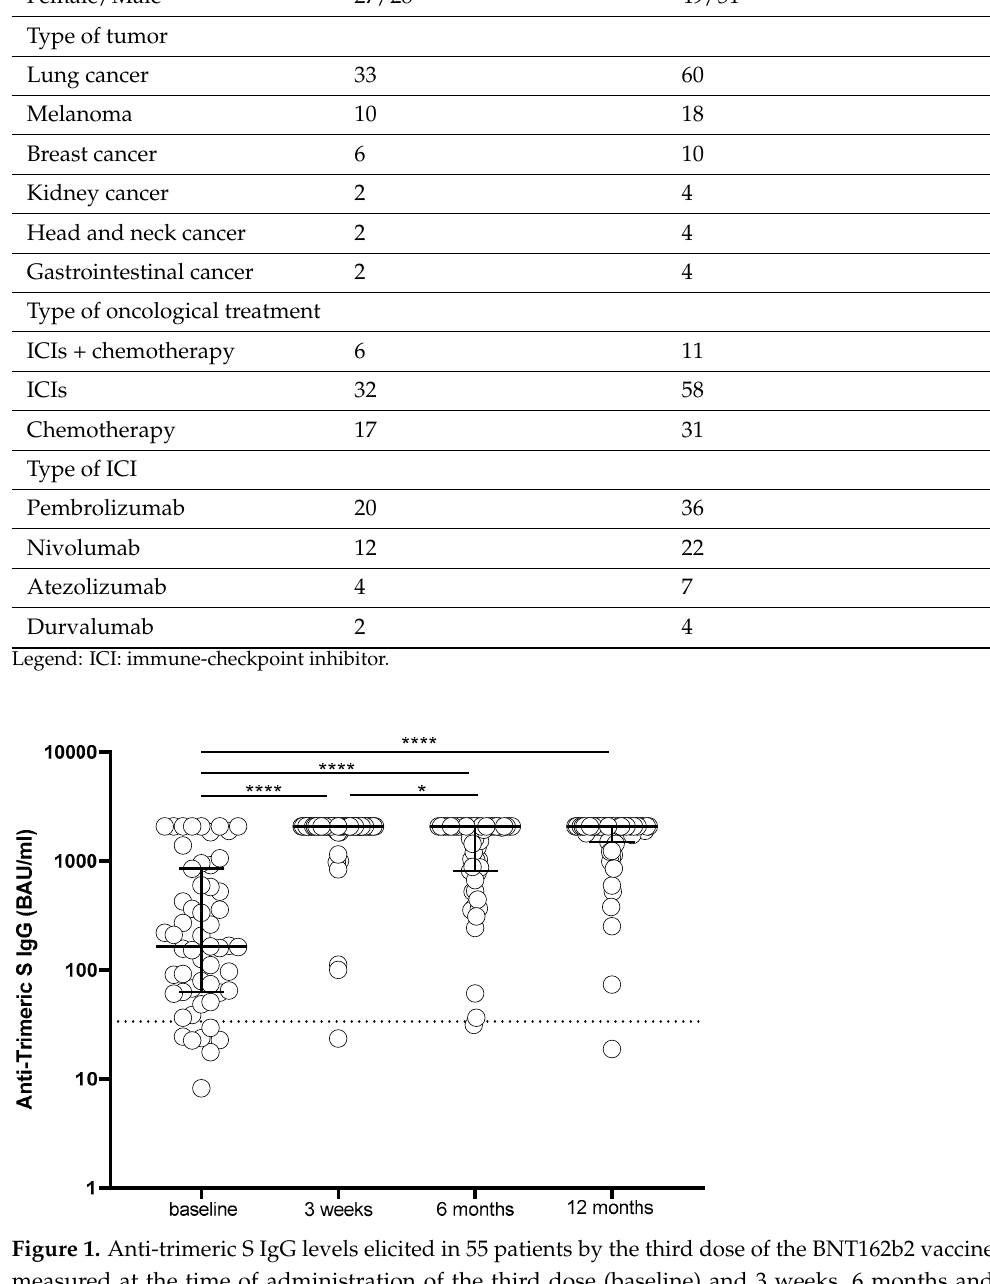
Table 1. Demographic and clinical characteristics of enrolled patients.